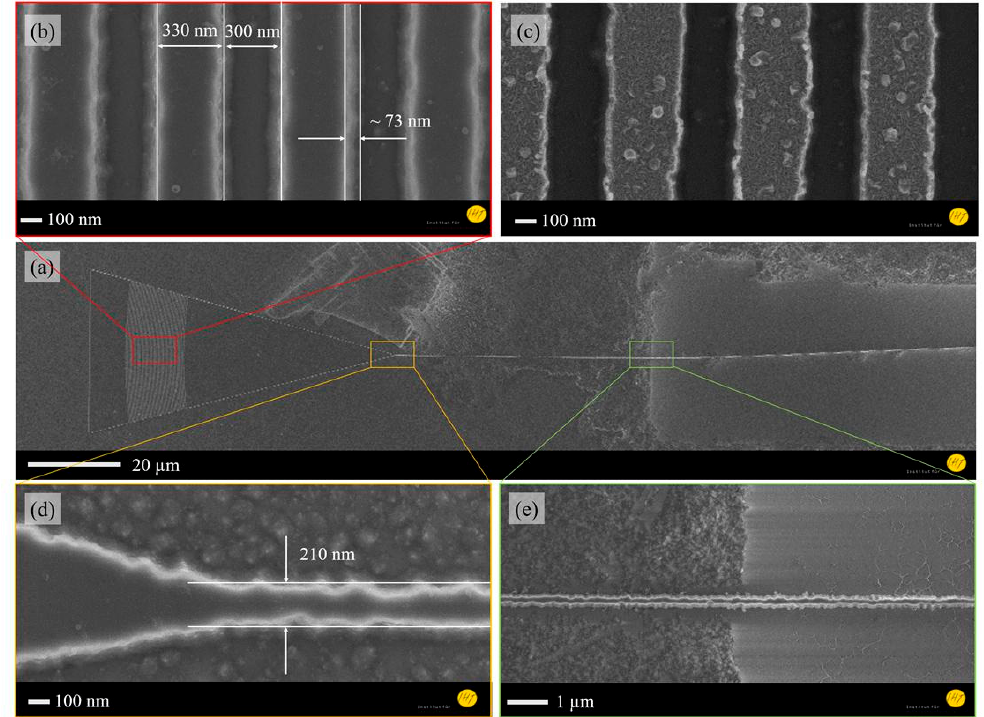
Figure 3. SEM images depicting ( a ) left part of microresonator comprising a grating coupler with connected NWG and suspended region, ( b ) a grating with line width of 330 nm and gap of 300 nm, ( c ) Cr mask used for ICP-DRIE, ( d ) interface between grating coupler und NWG, and ( e ) transfer area of solidly mounted NWG to suspended